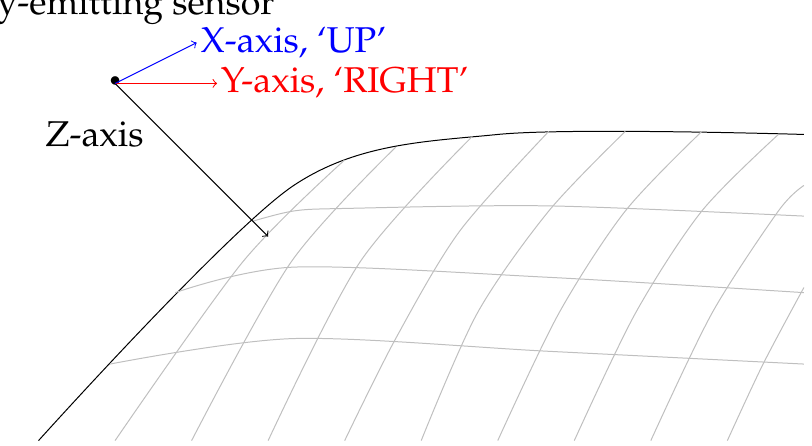
Figure 2. Flood Fill analogue in three dimensions. Grey lines represent iso-lines on the